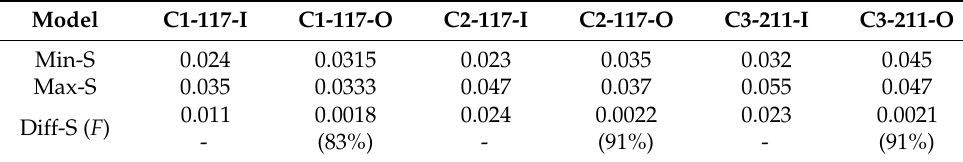
Table 4. Comparison of settlements of the rafts for different cases (m).